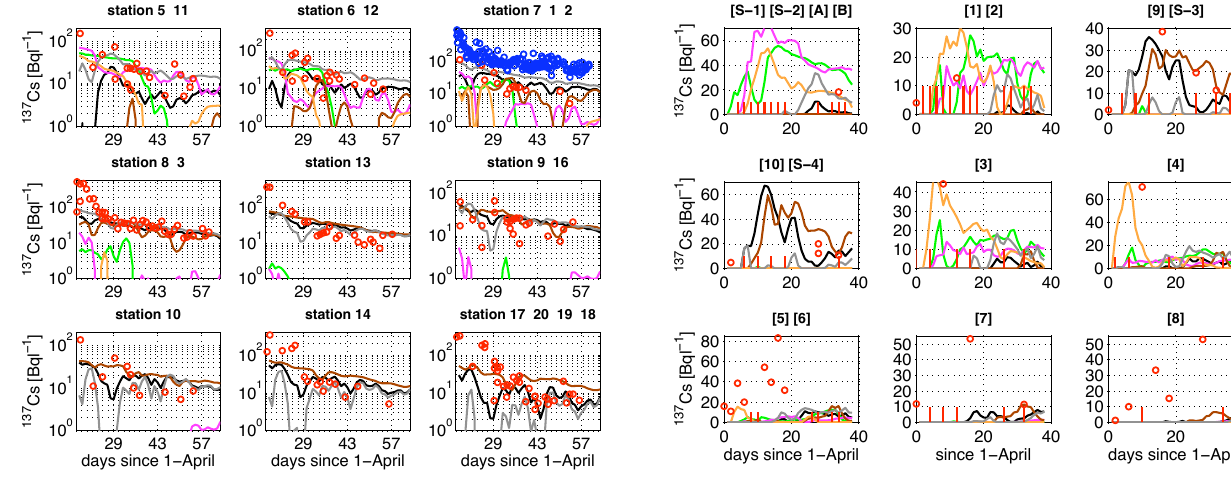
Fig. 7. Observed (red and blue o) by TEPCO and simulated (colored lines) time series of surface 137 Cs activities at different stations as indicated by panel titles. The station numbers are assigned to loca- tions in Fig. 2. The black, green, magenta, brown, orange lines cor- respond to simulated nominal years 1993 to 1997, respectively. The grey lines correspond also to simulated year 1993 but with 137 Cs depositions being applied one week later. The blue o in the upper right panel denote measurements at stations 1 & 2, close to the dis- charge point.